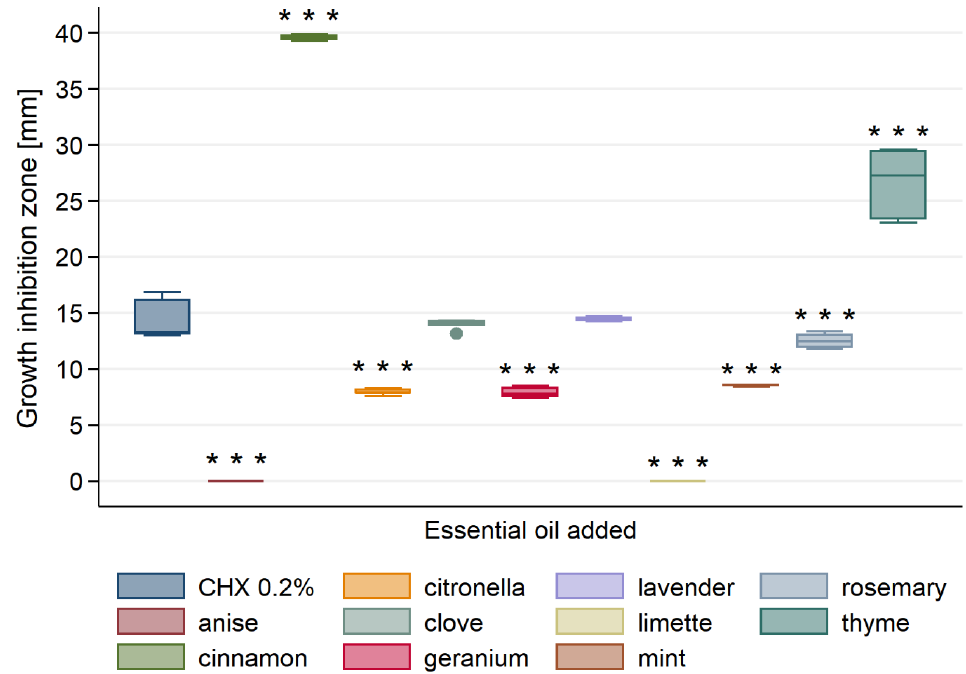
Figure 2. Antibacterial activity of tested essential oils against S. mutans . *** p < 0.001 versus positive control (0.2% CHX).